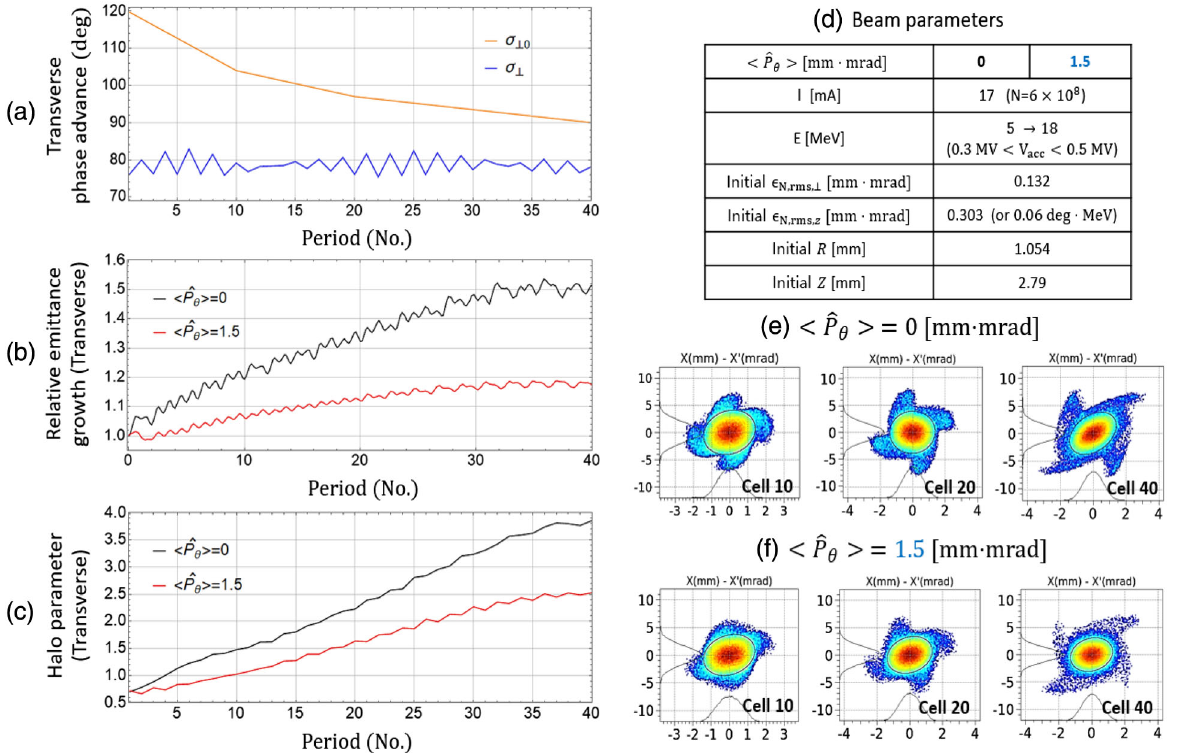
FIG. 7. (a) Transverse phase advances, (b) relative emittance growth, and (c) halo parameter of the nonspinning and spinning beams under the solenoid focusing lattice. Here, σ ⊥ 0 decreases from 120° to 90° (yellow line) as the beams are accelerated from 5 to 18 MeV over 40 periods. The depressed phase advance remains constant around σ ⊥ ∼ 76 ° along the linac (blue line), which is within the fourth- order resonance stop band. (d) The initial beam parameters for nonspinning and spinning beams are the same. Phase-space plots are ˆ P 0 and (f) h ˆ P 1 . 5 mm mrad beams. For the spinning beam, the population of particles in the four resonance shown for the (e) h θ i ¼ θ i ¼ islands is reduced, and the associated emittance growth and halo parameter evidently decrease (red lines). The initial longitudinal phase advance is σ z 0 ¼ 30 °, whereby there is no emittance exchange between the transverse and longitudinal